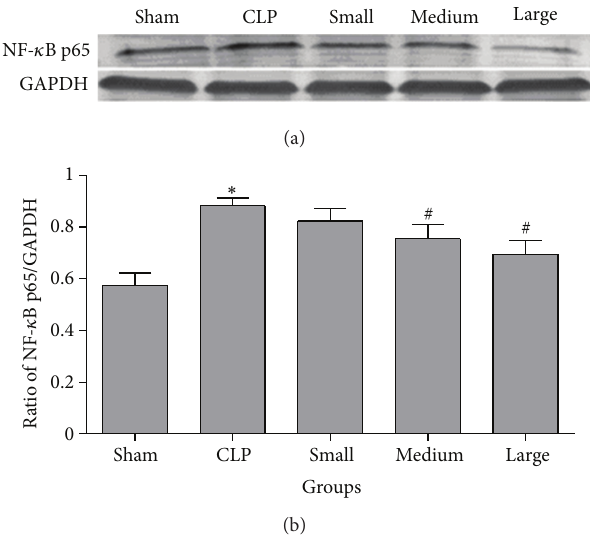
Figure 6: Effect of dexmedetomidine on NF- 𝜅 B p-65 activ- ity in lung nuclear extracts of septic rats by western